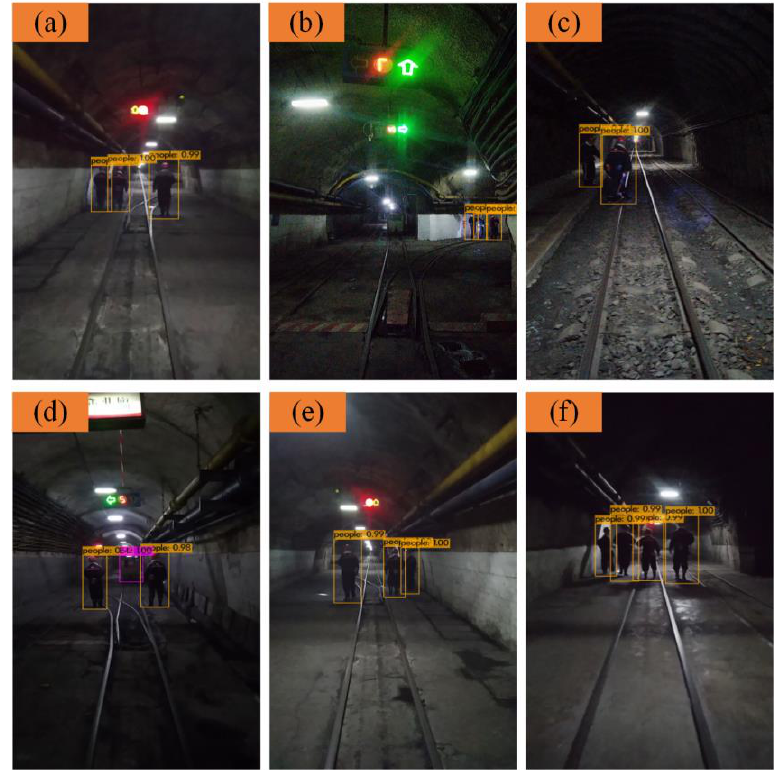
Figure 11. Improved YOLOv4 detection results for low-light scenes. ( a – f ) Example of test result.